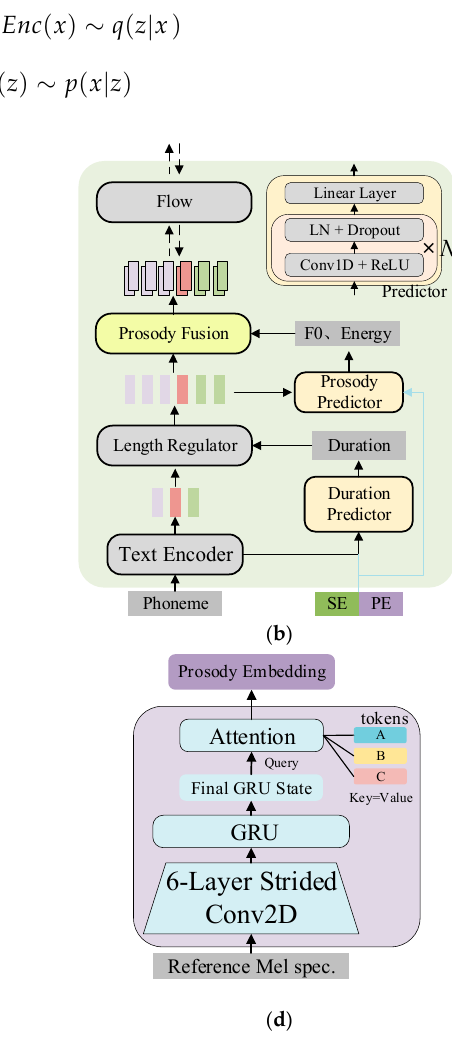
Figure 1. Model architecture scheme: ( a ) overall structure; ( b ) prior encoder (SE: speaker embedding, PE: prosody embedding); ( c ) prosody fusion (L: linear, LUT: lookup table); ( d ) prosody style extractor.